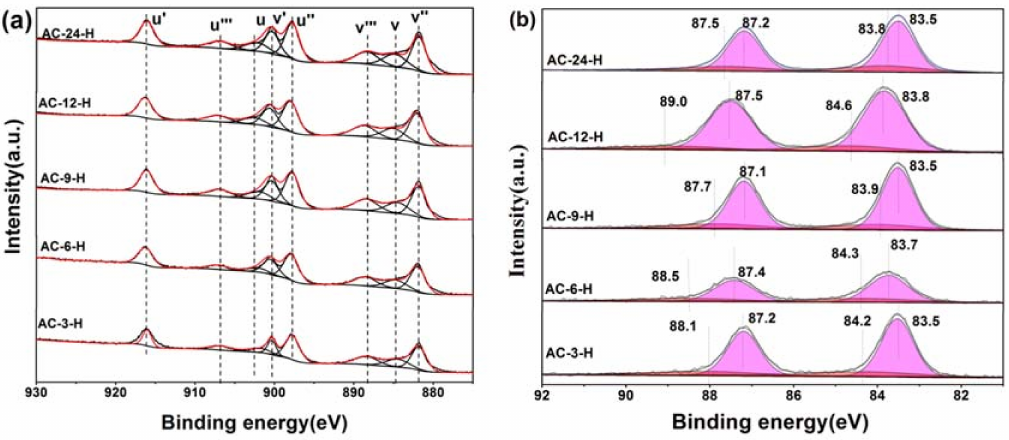
Figure 7. X-ray photoelectron spectra (XPS) of AC-3-H, AC-6-H, AC-9-H, AC-12-H and AC-24-H ( a ) Ce 3d; ( b ) Au